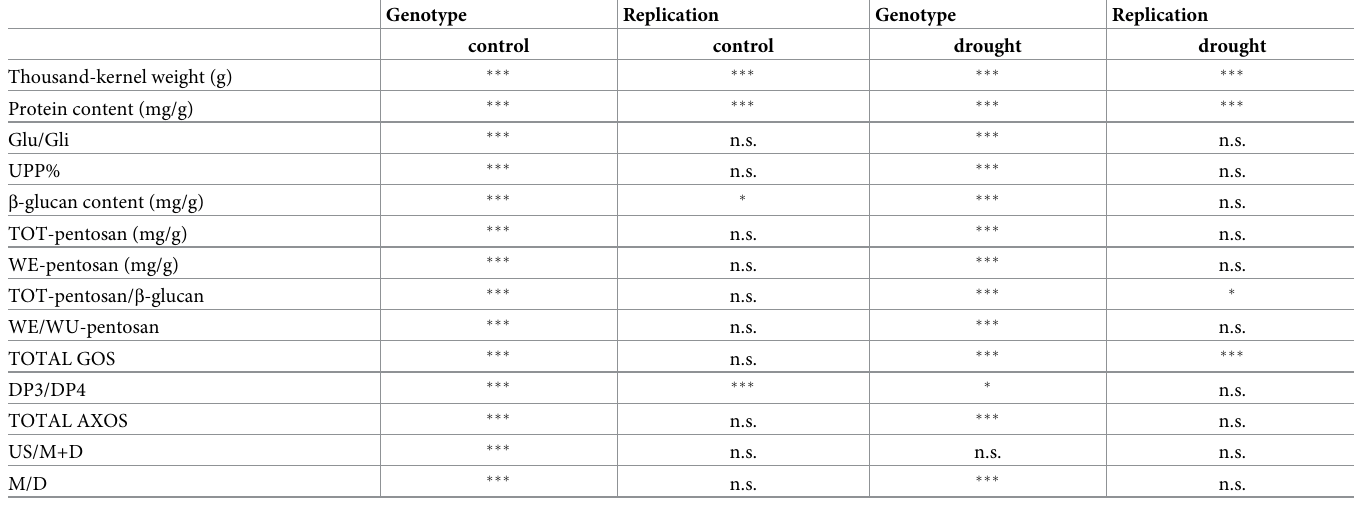
Table 2. Significance of main effects and their interactions for grain compositional traits split by treatment and tested using Linear Mixed Model